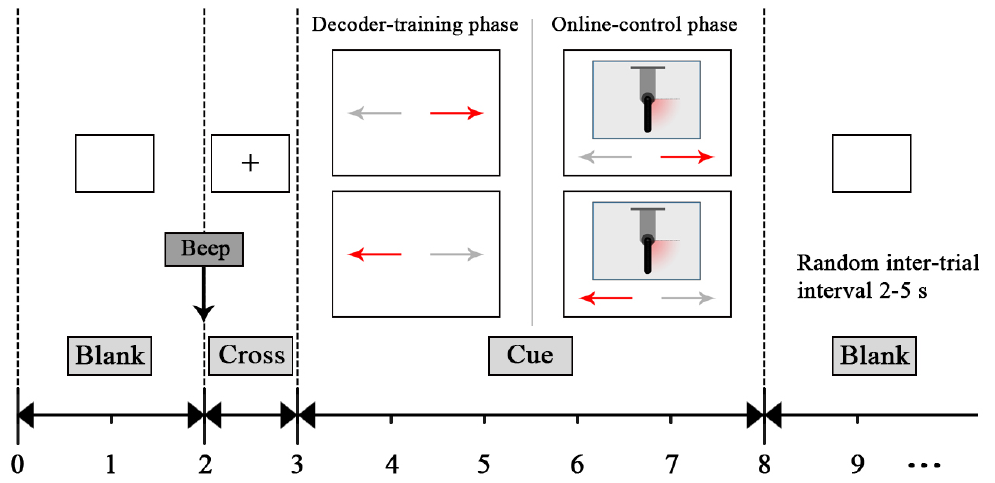
Figure 2. Timing of one trial used in the experiment. Each trial started with the presentation of an acoustical warning tone and a cross (second 2). One second later, a cue was randomly chosen in one of two (“ ← ” and “ → ”), which indicated the movement to be executed or imagined. This cue was presented visually by means of a left/right arrow, which appeared in the middle of the computer screen. Subjects had to perform the ME and MI for five seconds, until the screen content was erased (second 8). After a short pause (random duration between two and five seconds), the next trial